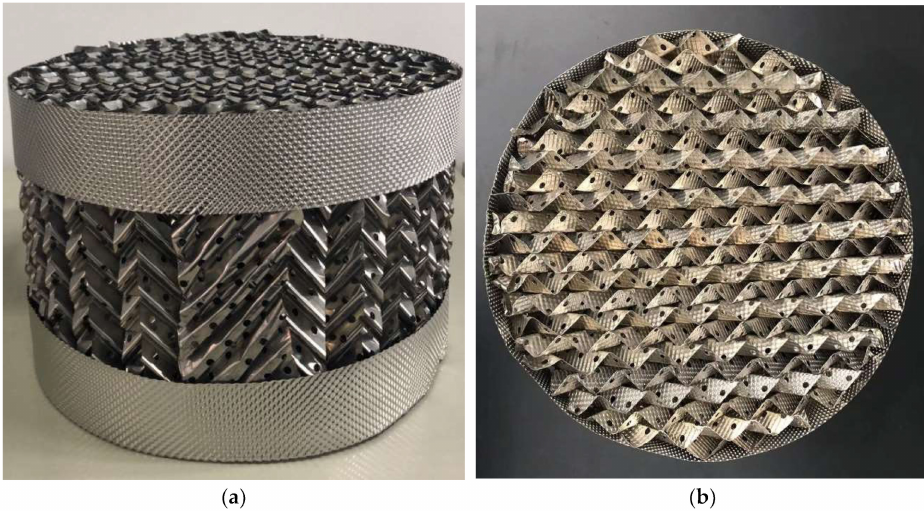
Figure 4. Carrier workpiece. ( a ) Carrier front view; ( b ) Carrier vertical